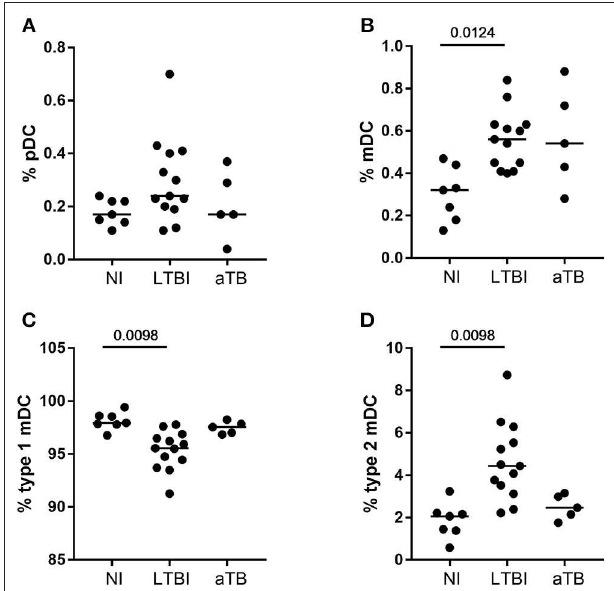
FIGURE 6 | Proportions of circulating plasmacytoïd and myeloïd DC subsets in M. tuberculosis -infected compared to non-infected children. (A,B) The proportions of pDC and of total mDC were evaluated in the peripheral blood of non-infected children (NI), children with a latent TB infection (LTBI), or with active TB (aTB) and the results were expressed as percentages among CD45 + cells (upper panels). (C,D) The proportions of type 1 and type 2 mDC subsets are those among the total mDC (lower panels). Horizontal lines represent the medians of percentages. Statistical analysis was performed by a Kruskal-Wallis test followed by Dunn’s